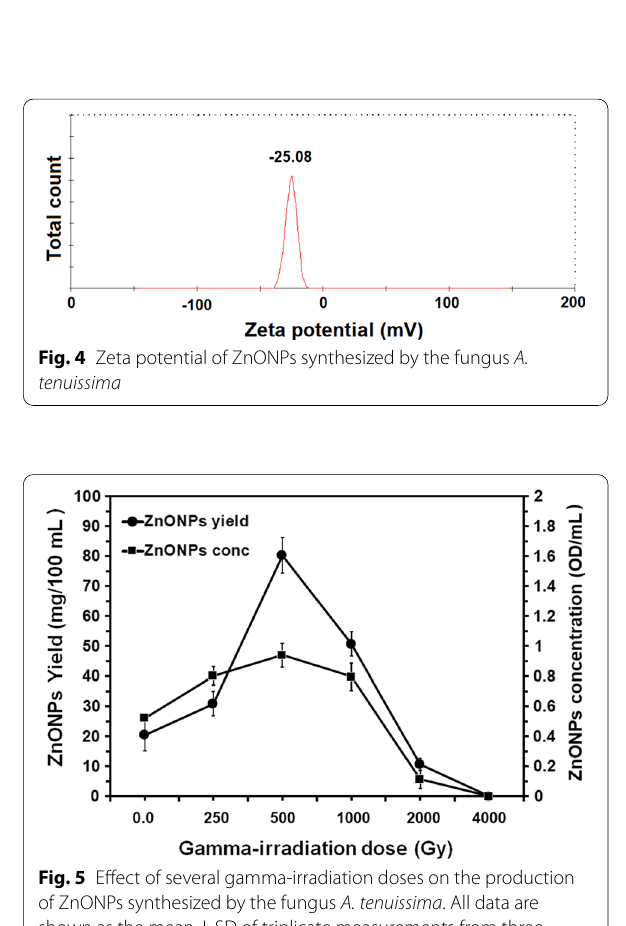
Table 1 Physicochemical properties of the prepared films Film